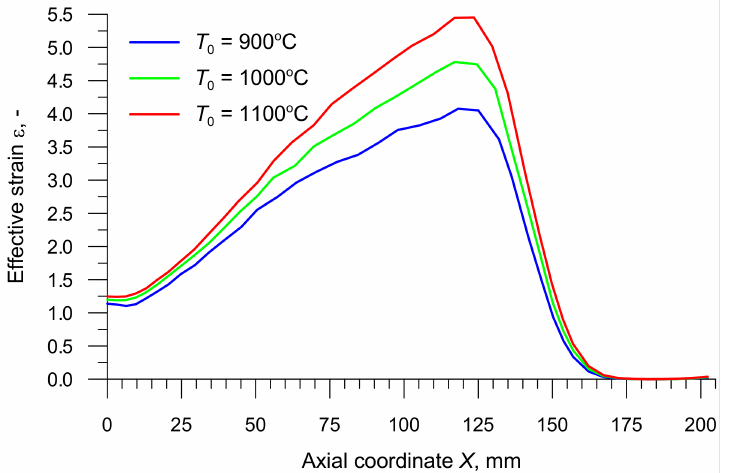
Figure 14. Effective strain in the axial zone of the specimen versus billet temperature T 0